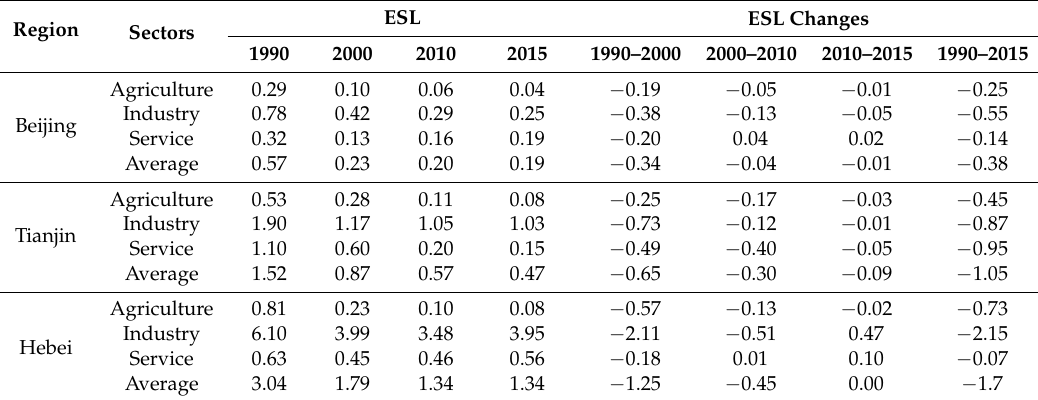
Table 4. The ecosystem service load (ESL) from 1990 to 2015 in the Jing-Jin-Ji